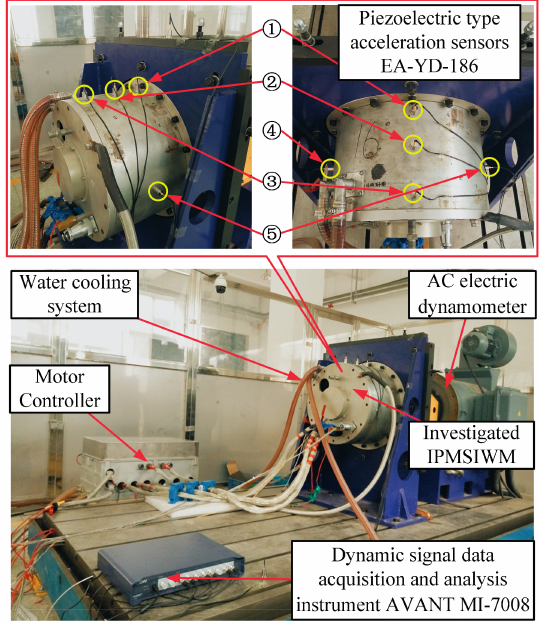
Figure 16. Experimental platform for the investigated IPMSM prototype.